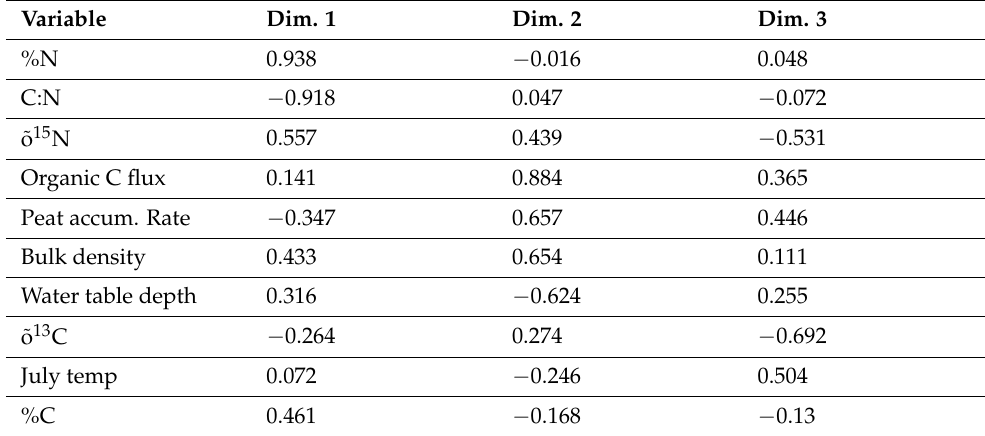
Table 3. Correlation coefficients for PCA ( p values are all